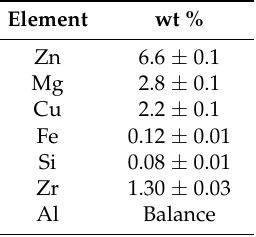
Table 1. The chemical composition of the gas atomized Al7075Zr alloy determined by XRF. Element